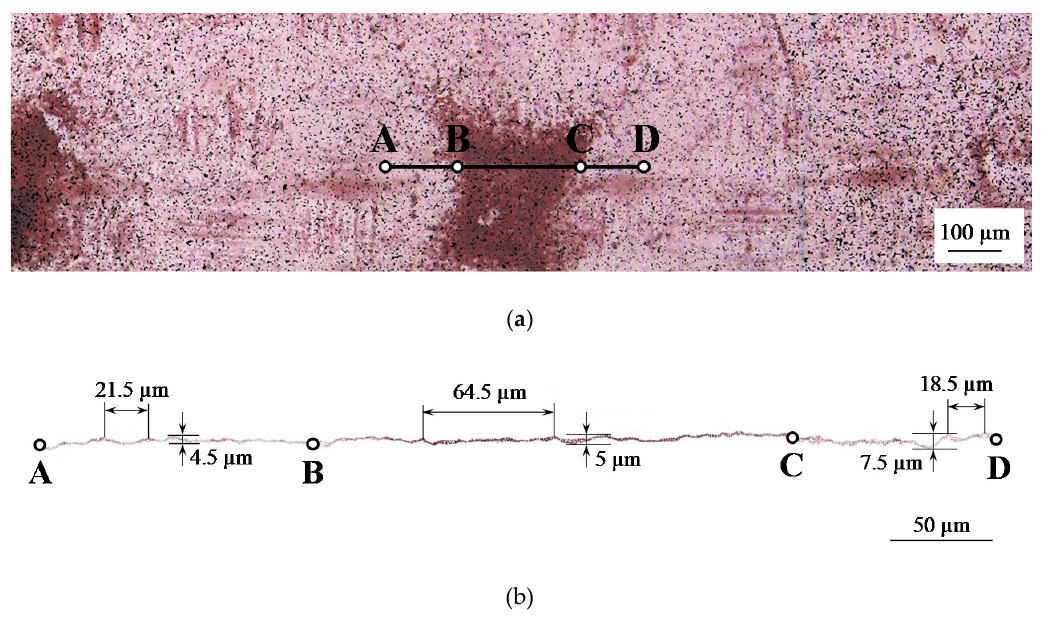
Figure 6. Image of the modified surface with reference points ( a ) and surface profile ( b ) of the AMX-Sb 2 membrane. Points A and D limit the considered segment of the membrane surface; B and C refer to the boundaries of the fluoropolymer